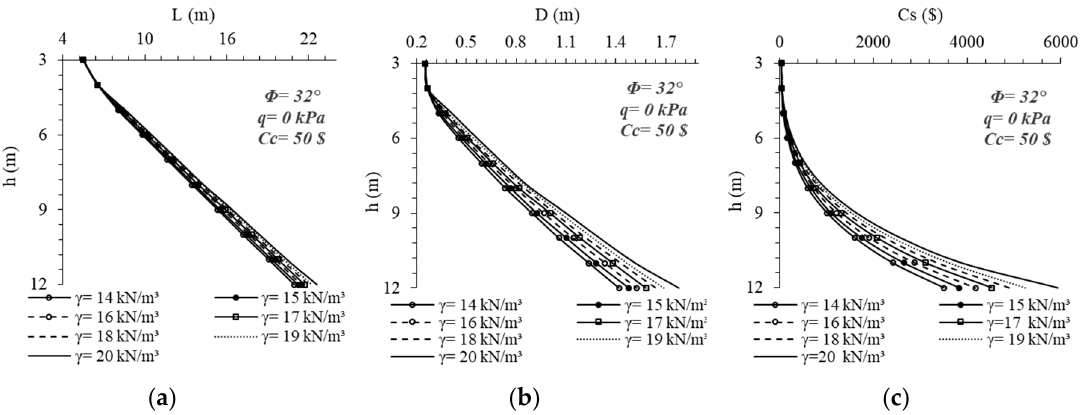
Figure 8. The e ff ects of the change of soil unit weight to the diameter of the cantilever soldier pile ( a ), the length ( b ), and the unit cost of pile ( c ) (for h = 6 m excavation depth) via the excavation